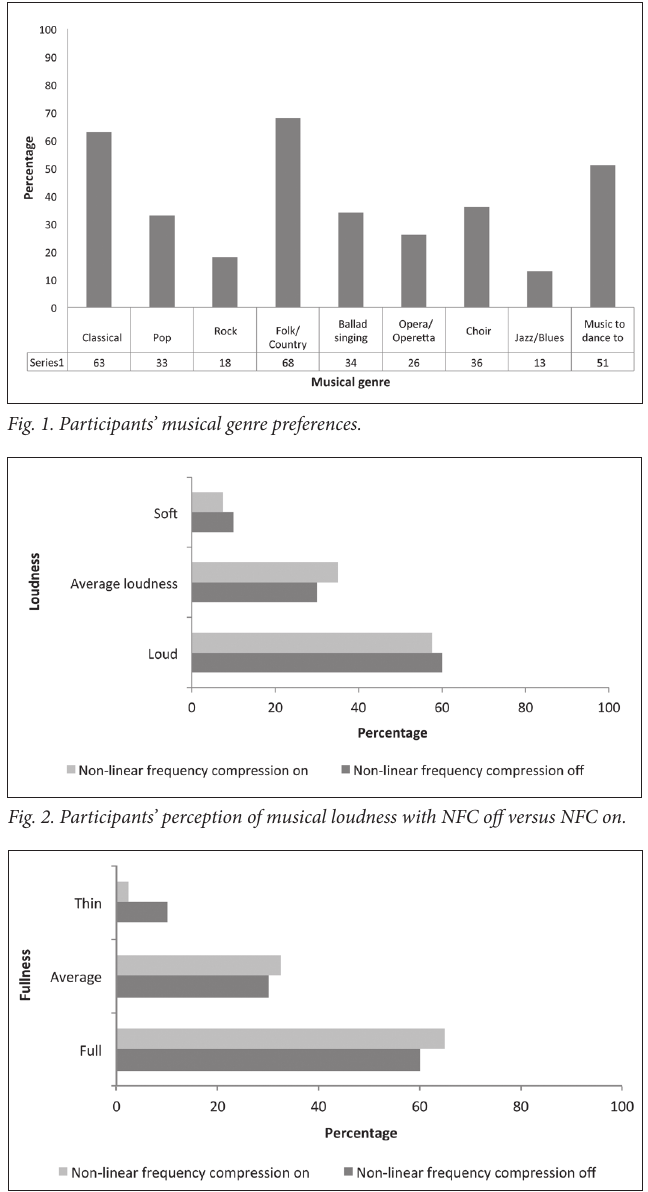
Fig. 3. Participants’ perception of the fullness of music with NFC off versus NFC on.